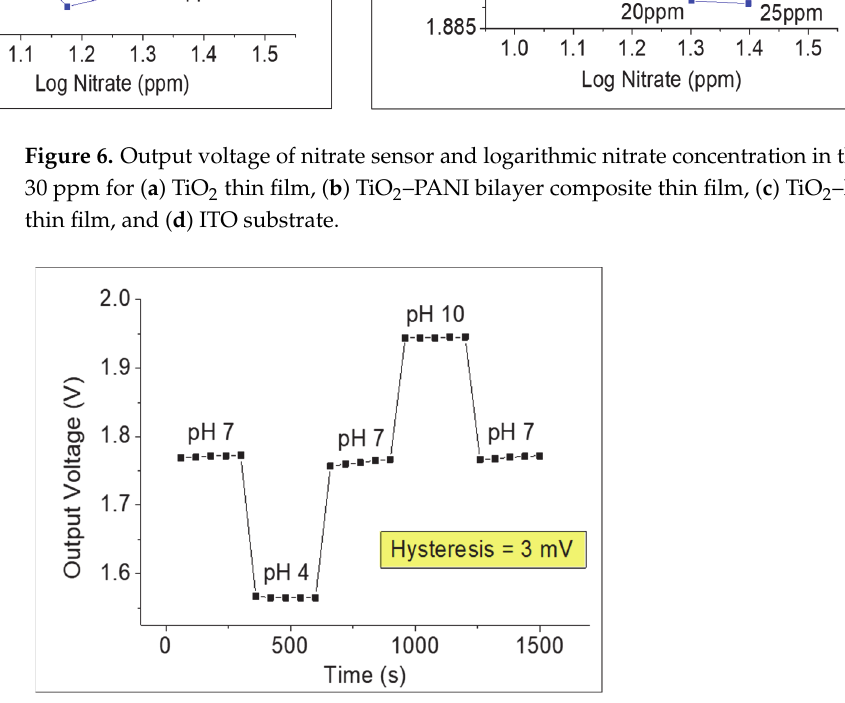
Figure 7. Hysteresis characteristic of composite TiO 2 –PANI thin film in pH loops of 7  4  7  10 